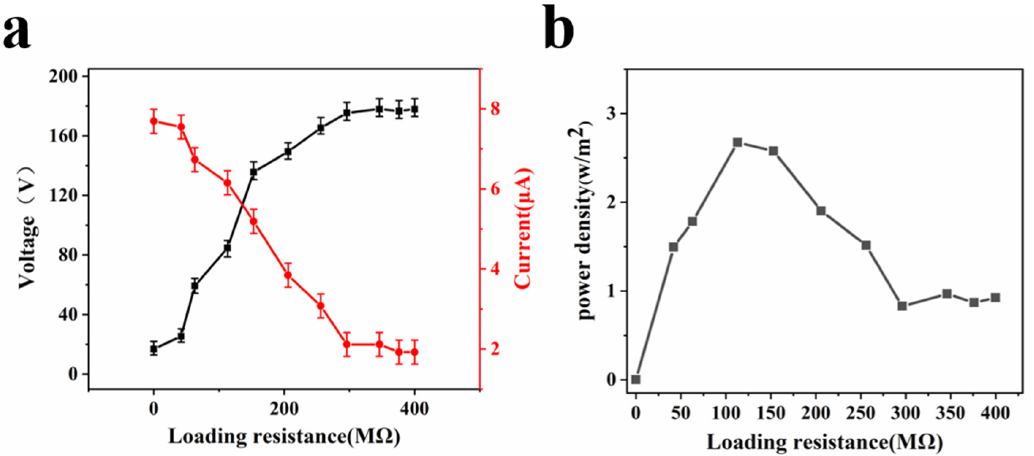
Figure 6. Relationship of load resistance on output of voltage and current. ( a ) Relationship of load resistance on output of voltage; ( b ) relationship of load resistance on output of current.